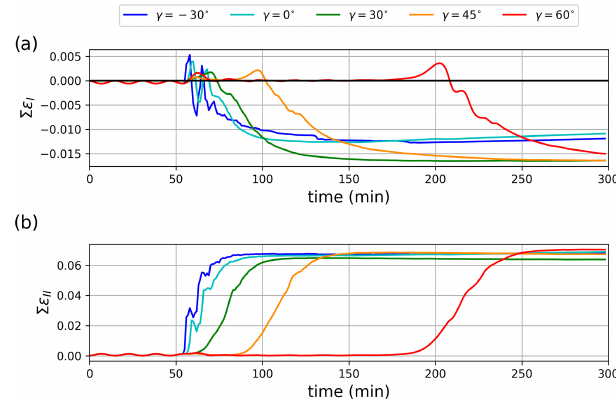
Figure 8. Time evolution of the mean normal (a) and maximum shear (b) strain rate invariants integrated over the ice cover, in sim- ulations using the generalized damage parameterization with a dif- ferent stress correction path γ